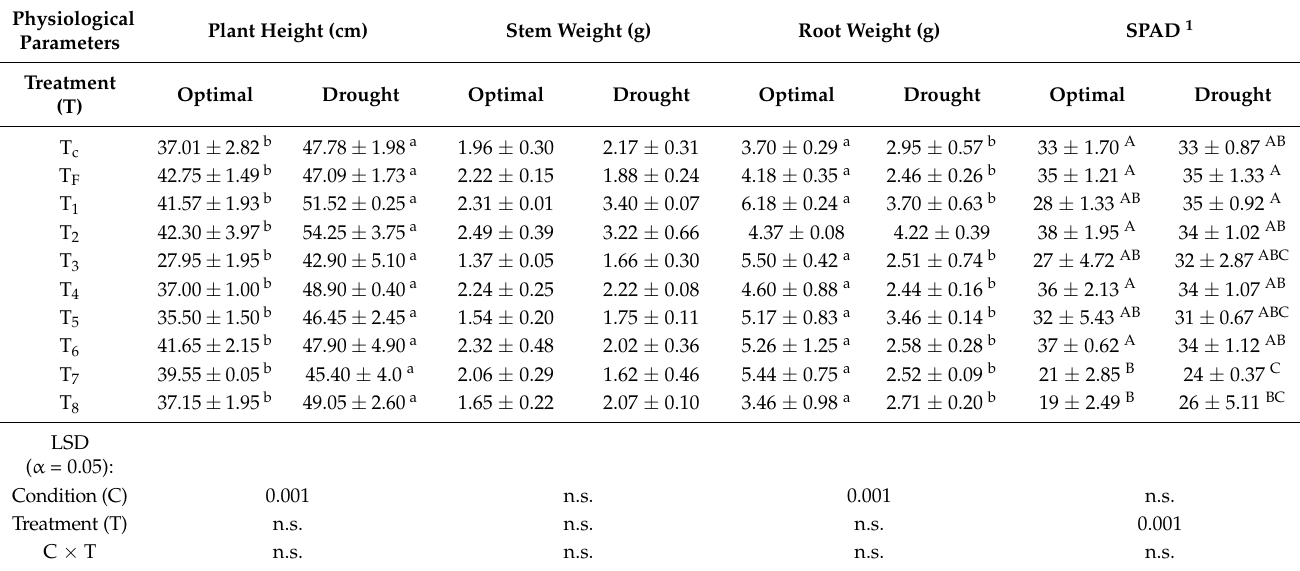
Table 3. Effects of drought stress and fertilizer treatment on growth parameters of 21-day-old maize seedlings grown in climate